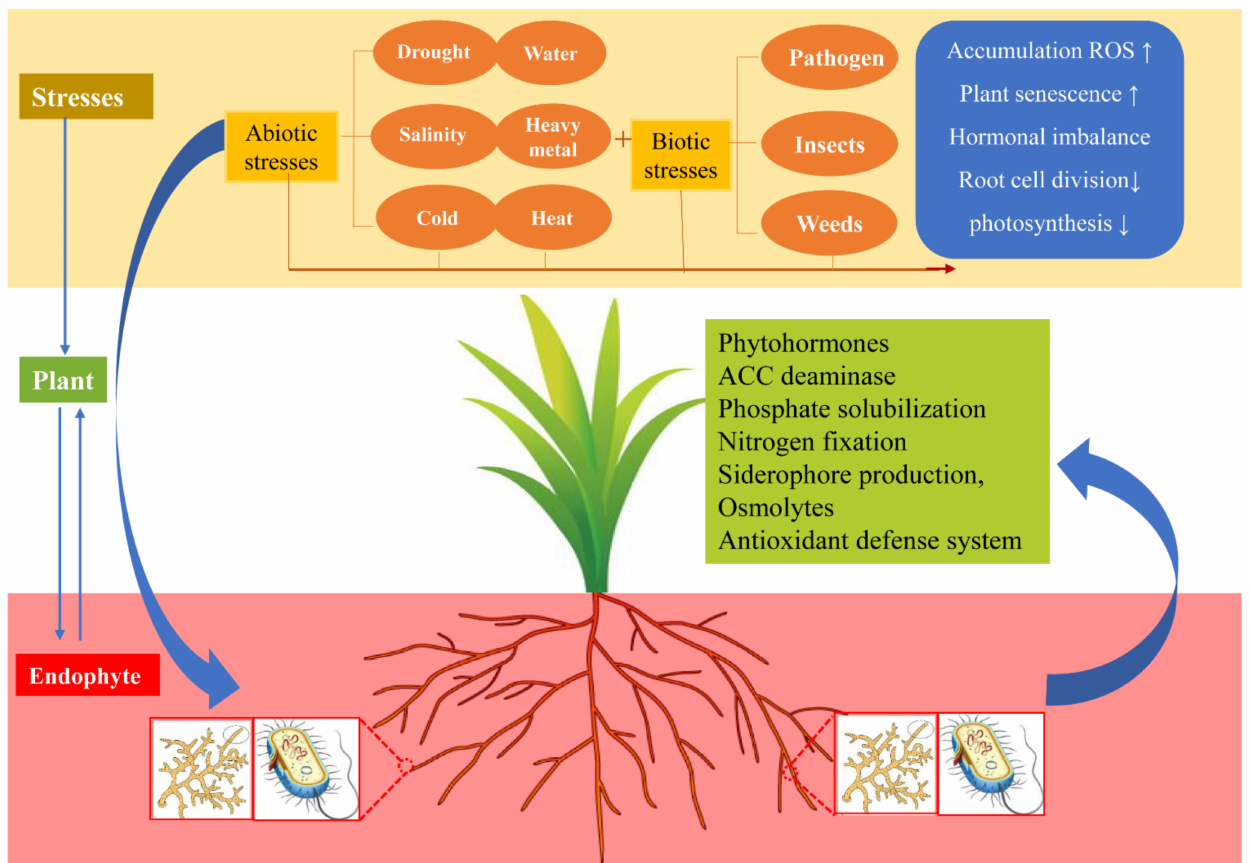
Figure 4. The plant–endophyte relationship between biotic and abiotic stress environments. Plants are subjected to a variety of biotic and abiotic stresses throughout their life, resulting in ROS accumulation, increased plant susceptibility, decreased photosynthesis, and decreased root differentiation, thus inhibiting growth and reproduction. In turn, the colonization of endophytes in plant tissues is conducive to the plant tolerance to a variety of stresses, which can promote plant growth and the bioavailability of nutrients, secrete antioxidants to reduce ROS damage, promote ACC deaminase to reduce ethylene decline, and produce siderophore to maintain iron homeostasis. Abbreviations: 1-aminocyclopropane-1-carboxylic acid (ACC), reactive oxygen species